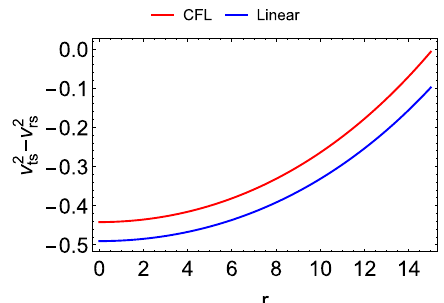
Fig. 7 Variation of stability with radial coordinate